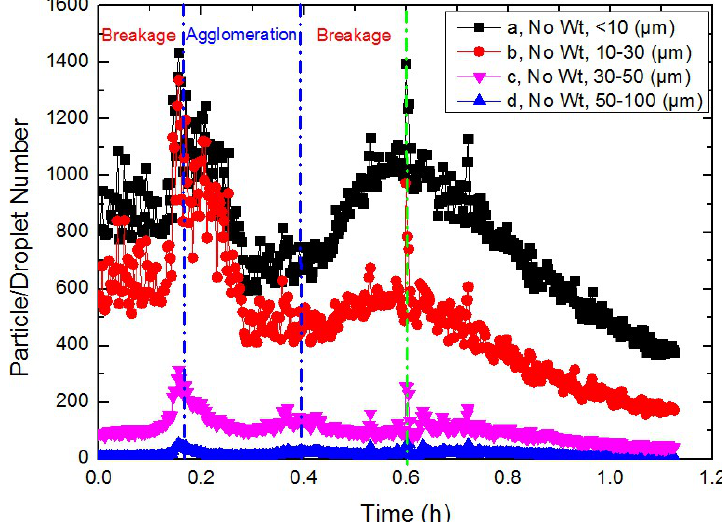
Figure 6. Variation trends of particle/droplet numbers during hydrate slurry dissociation.